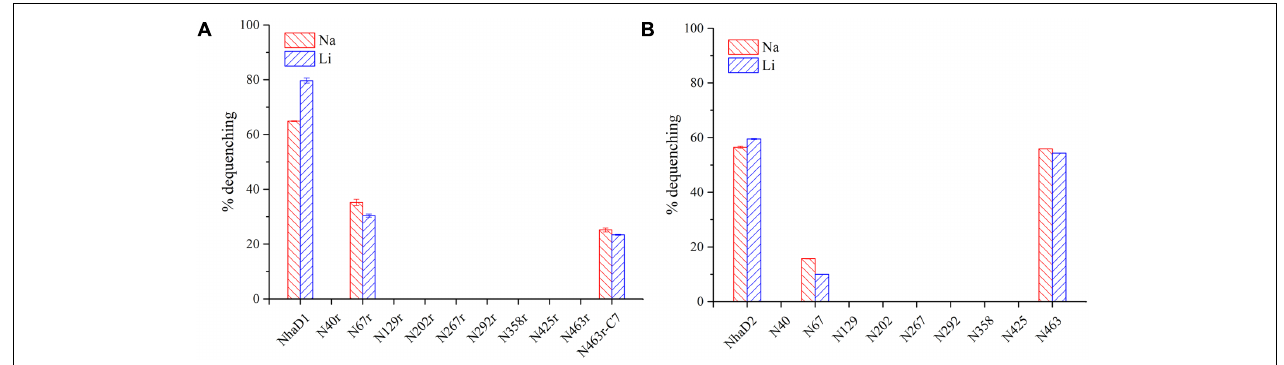
FIGURE 2 | Fluorescence-based antiport activities of chimerical proteins in sub-bacterial vesicles. (A) Na + and Li + antiport activities of NhaD1 chimerical proteins. (B) Na + and Li + antiport activities of NhaD2 chimerical proteins. The transport activities were measured in the assay buffer containing 10 mM Tris-MES (pH 8.5),